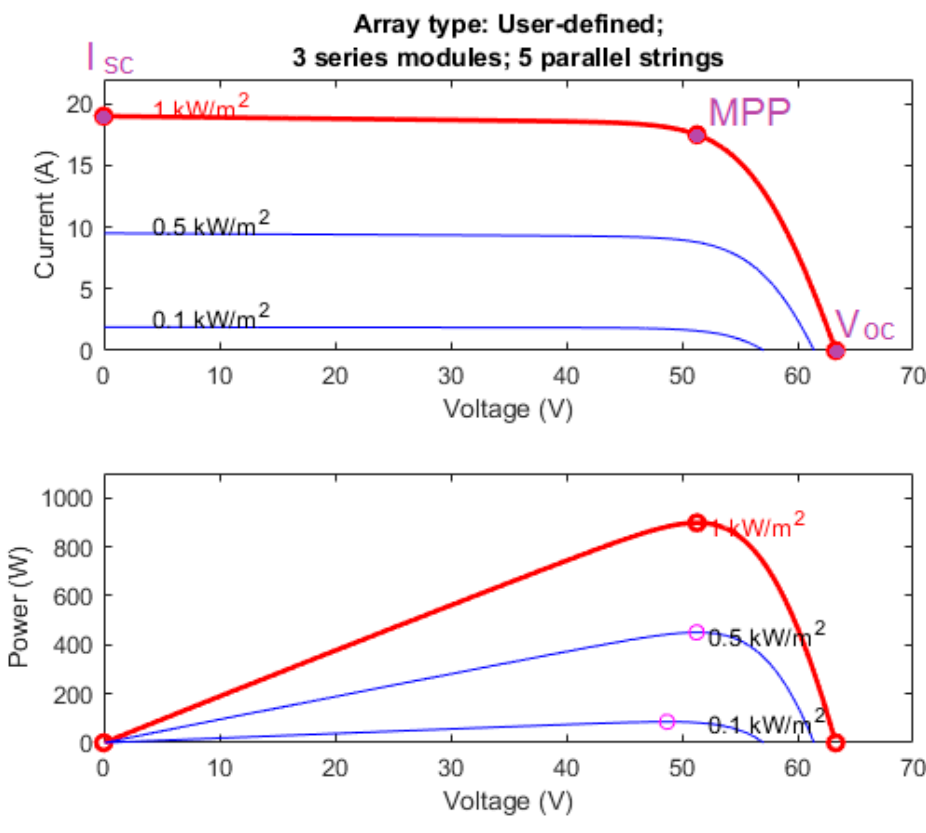
Figure 6. The I-V curves and the P-V curves for the PV array for a temperature of 25 °C and three values of the incident irradiances: 0.1, 0.5, and 1 kW/m 2 , respectively.